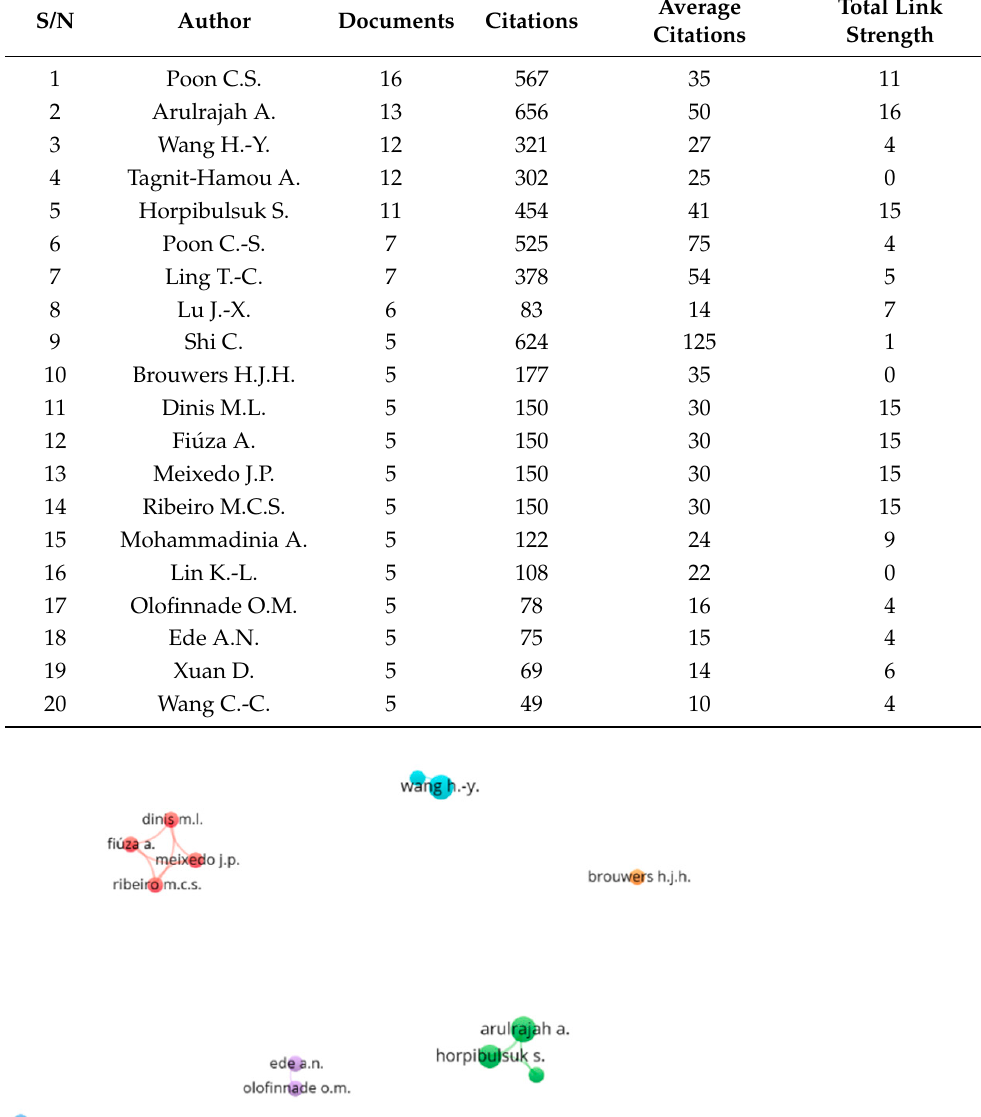
Table 3. Top researchers.